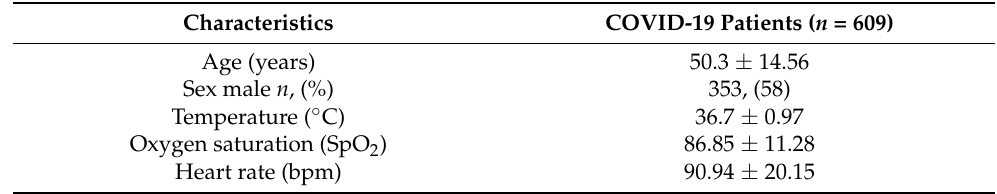
Table 1. Clinical data and biochemical parameters of the COVID-19